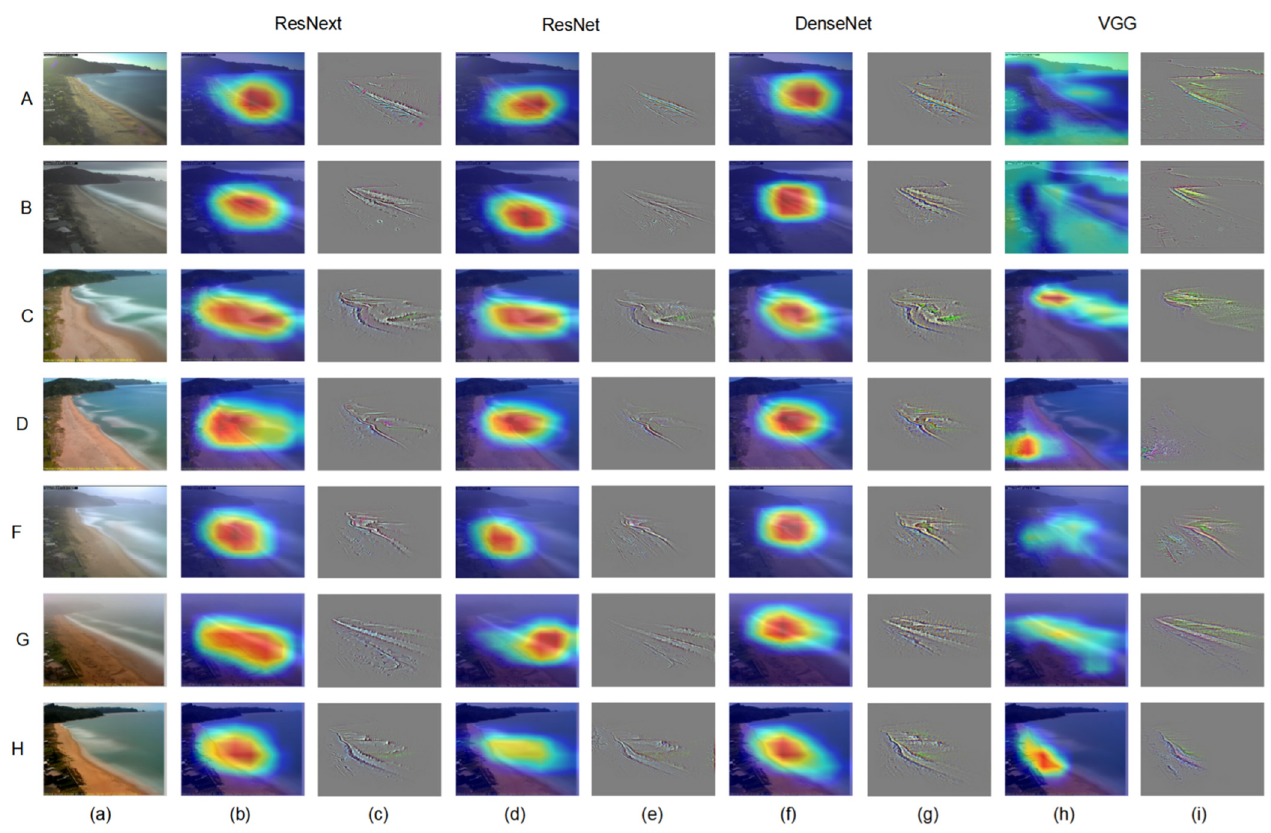
Figure 5. Comparison of visual results for different networks. ( a ) Original images for classes A, B, C, D, F, G, H. ( b , d , f , h ) Grad-CAM: locates category-distinguishing regions according to various visualizations for ResNext, ResNet, DenseNet, and VGG. Brighter colors in the graph represent higher category scores. ( c , e , g , i ) Guided Grad-CAM: high-resolution visualization of texture information used for category differentiation. Note that all these visualizations are based on features from the last CNN layers (before the fully connected layer).